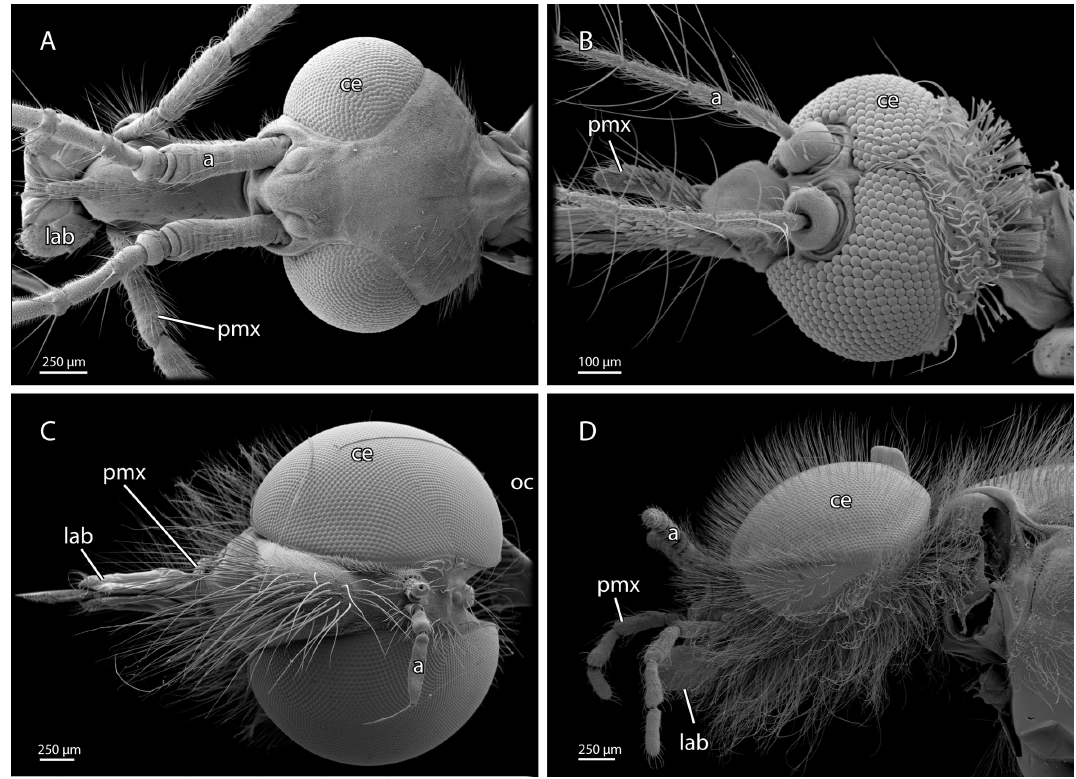
Figure 8 . Head capsule, SEM images. A, Tipula paludosa (Tipulidae), dorsal. B, Culex pipiens (Culicidae), laterodorsal. C, Silpnogaster aemula (Asilidae), dorsal. D, Bibio sp. (Bibionidae), lateral, copyright Hans Pohl. Abbreviations: a, antenna; ce, compound eye; lab, labella; oc, ocelli; pmx, maxillary